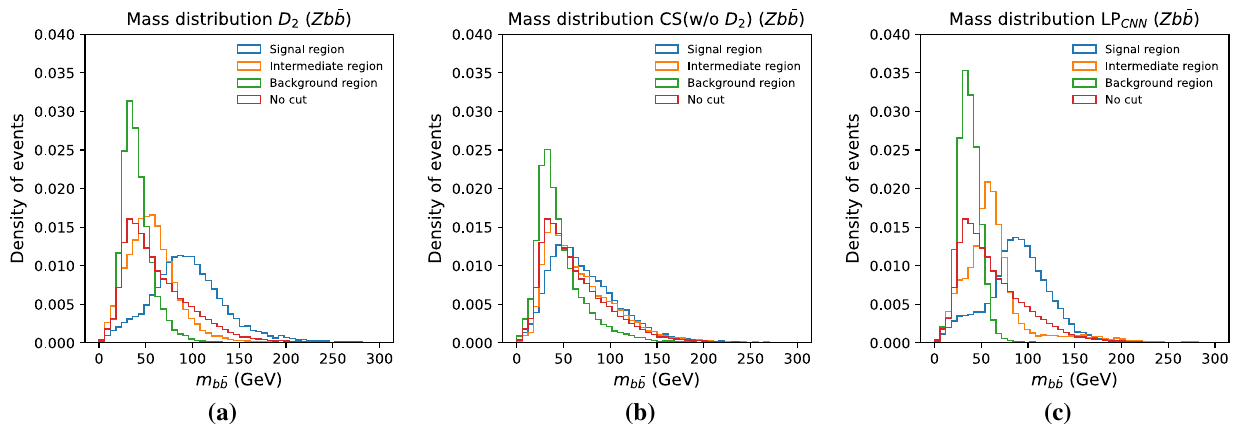
Fig. 5 The distribution of the invariant mass of the b -jets pair in the reco background sample for a different cuts on D 2 , b different ranges of the BDT output for the CS without the inclusion of D 2 , c and for different cuts on Lund plane CNN